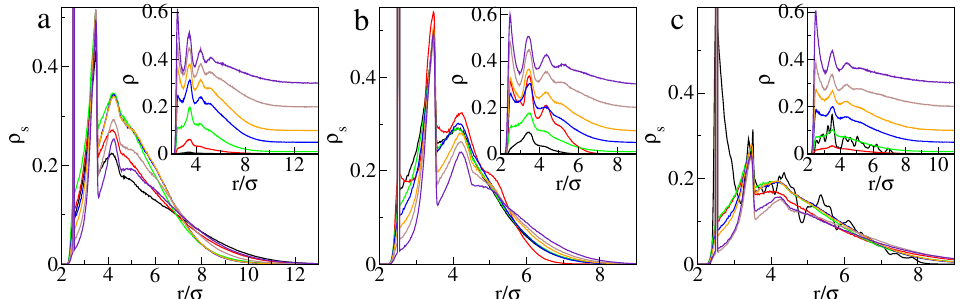
Figure 3. Density profiles of the chain segments and fluid particles (insets) around the core for the model M1 plotted for different initial densities of the fluid ρ 0 = 0.0001 (black), 0.001 (red), 0.01 (green), 0.05 (blue), 0.1 (yellow), 0.2 (brown), and 0.3 (violet): ( a ) f = 20 , M = 20, ( b ) f = 20, M = 10, ( c ) f = 10, M = 20. Other parameters: σ c = 4 σ , ε Ps = 1.5 ε